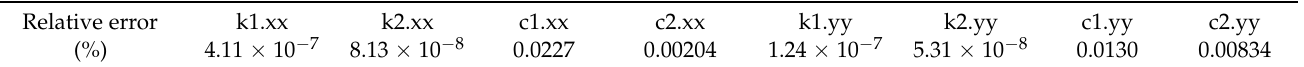
Table 6. The biggest relative error of the identified main coefficients based on Algorithm I and g1.4.